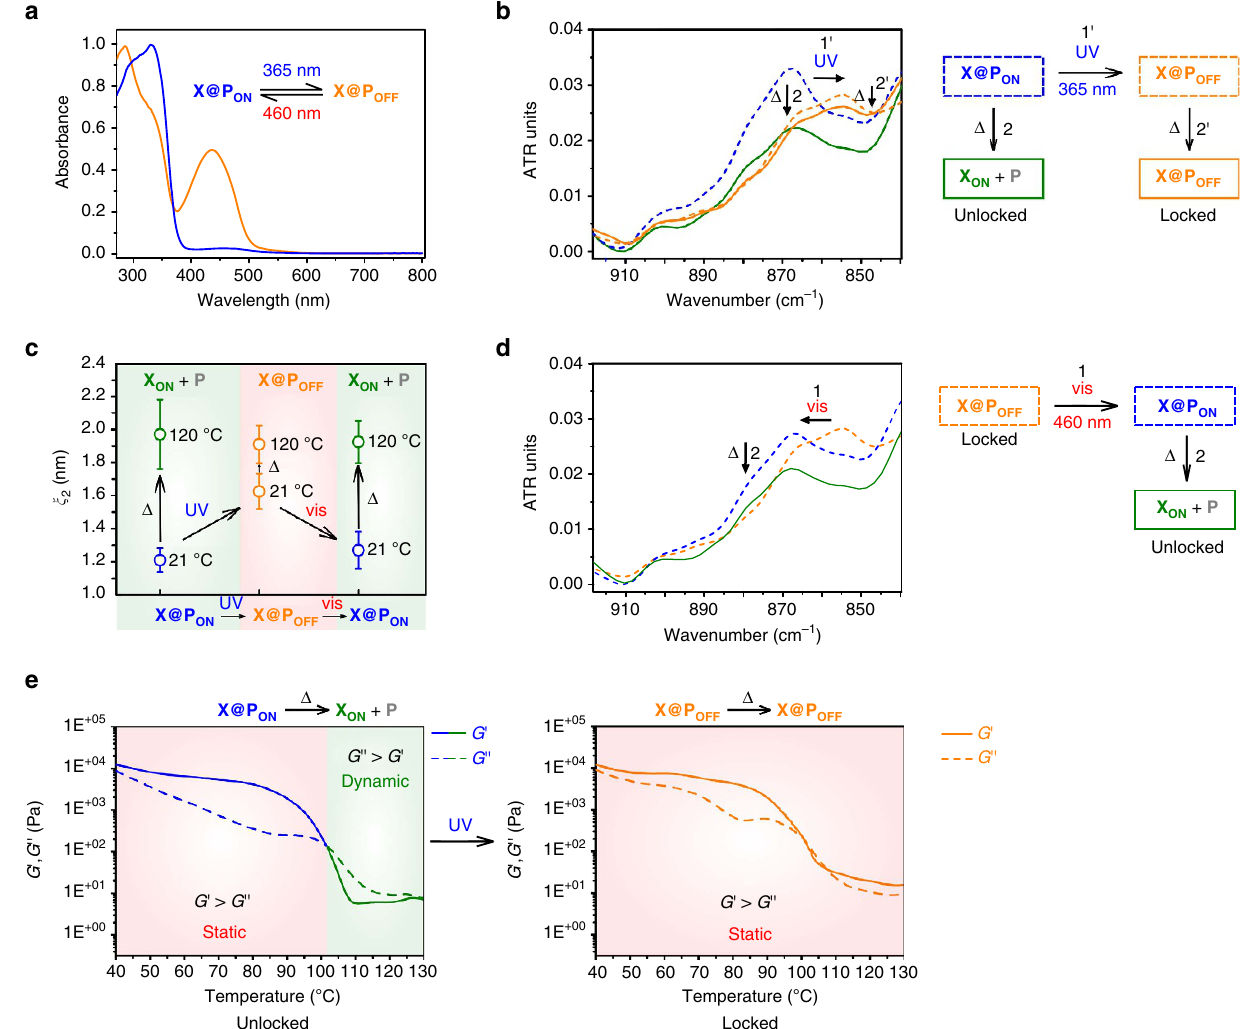
Figure 3 | Characterization of individual states during a light-controlled healing cycle. ( a ) Normalized solid state ultraviolet/visible spectra of X@P ON on illumination with a 365nm LED for 8min to form the ring-closed isomer X@P OFF (83% photoconversion in photostationary state, Supplementary Fig. 11 and Supplementary Note 4). ( b ) FT-IR spectra of X@P ON and X@P OFF recorded at 25 (cid:2) C and after heating to 124 (cid:2) C for 5min in vacuum. ( c ) Mesh sizes of X@P ON , X ON þ P and X@P OFF measured by SAXS (scattering curves: Supplementary Figs 5, 12, 13 and 20, overview over mesh sizes: Supplementary Tables 1–5, further explanation: Supplementary Note 3). ( d ) FT-IR spectra of X@P OFF (recorded at 25 (cid:2) C) and X@P ON regenerated on illumination with 460nm LED for 105min (recorded at 25 (cid:2) C and after heating to 124 (cid:2) C for 5min in vacuum). ( e ) Temperature dependence of shear storage modulus G 0 and shear loss modulus G 00 of X@P ON and X@P OFF group in X@P OFF is clearly visible (Fig. 3b, blue dashed lines to yellow dashed lines) 31 . Interestingly, on ultraviolet-illumination the molecular basis of these macroscopic changes can be monitored mean polymeric mesh size increases from x 2 ¼ (1.21 ± 0.07) nm for by FT-IR spectroscopy. While heating of X@P ON above 120 (cid:2) C X@P ON to x ¼ (1.61 ± 0.10) nm for X@P OFF as determined by results in a significant decrease in the vinyl group’s C–H bending 2 signal clearly indicating the de-crosslinking process, (Fig. 3b, blue dashed line to green solid line) heating X@P OFF to the same temperature retains the spectral features demonstrating the suc- cessful inhibition of the retro Diels–Alder reaction by light (Fig. 3b, yellow dashed line to yellow solid line). Examining the thermo-rheological behaviour of X@P ON reveals a typical drop of the shear storage modulus G 0 below the loss modulus G 00 above 100 (cid:2) C that is well documented for Diels–Alder cross-linked polymers 32,33 and verifies the dynamic de-crosslinking process (Fig. 3e, blue to green lines). In stark contrast, X@P OFF retains its static viscoelastic properties on heating, that is, G 0 4 G 00 regardless of the temperature, providing additional proof for the successfully inhibited retro Diels–Alder reaction on the ultraviolet-